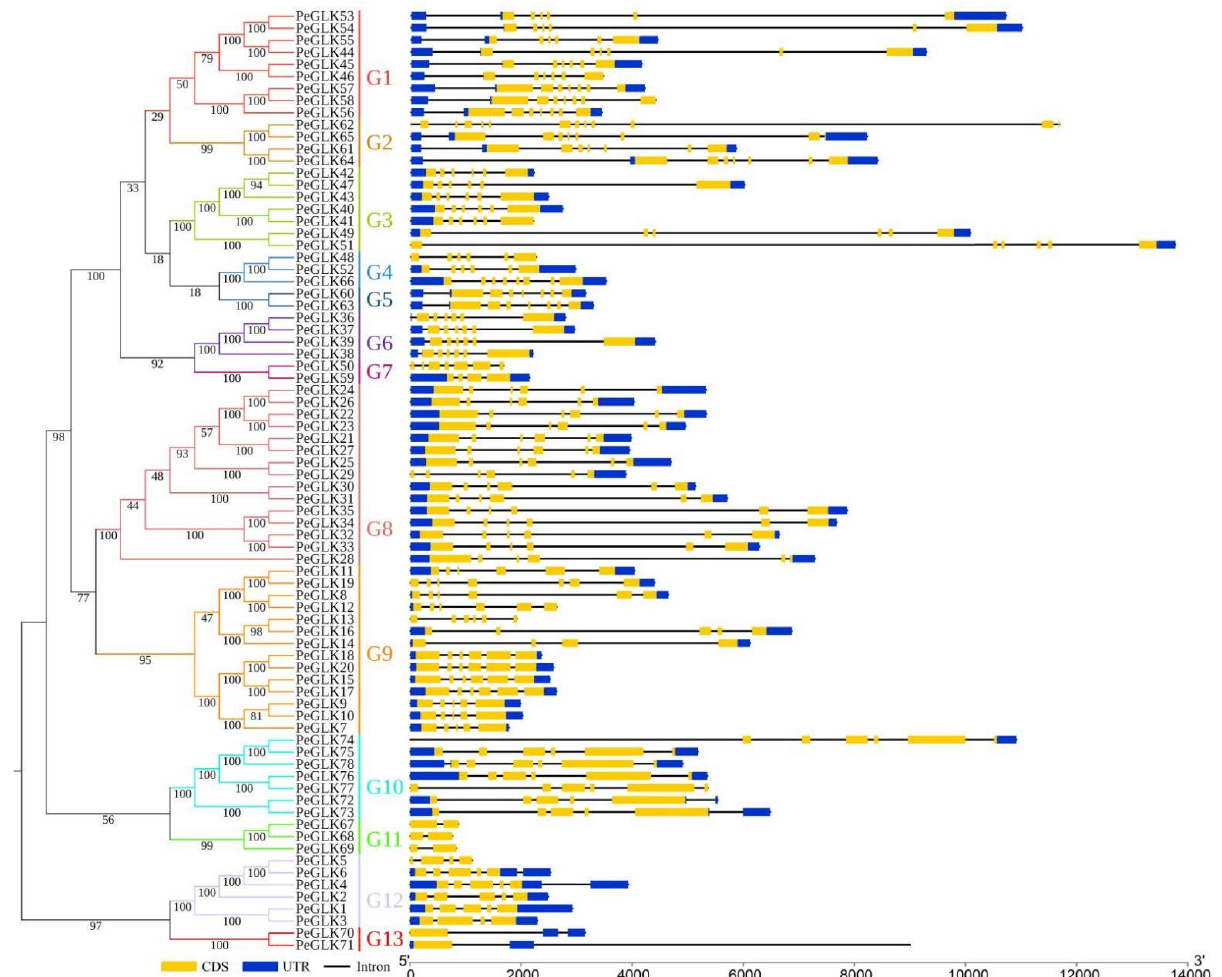
Figure 3. Phylogenetic relationship and gene structures of PeGLKs . Left: Neighbor-joining (NJ) phylogenetic tree was constructed by MEGA 7.0 according to PeGLK protein sequences. Proteins in tree were divided into 13 distinct subfamilies, which are distinguished by different colors. Right: Exon/intron structures of PeGLK genes were generated by online GSDS. Yellow rectangles, gray lines, and blue rectangles represent exons, introns, and untranslated regions (UTRs), respectively. The numbers at nodes indicate the bootstrap values per 1000 replicates determined by the neighbor ‐ joining method.